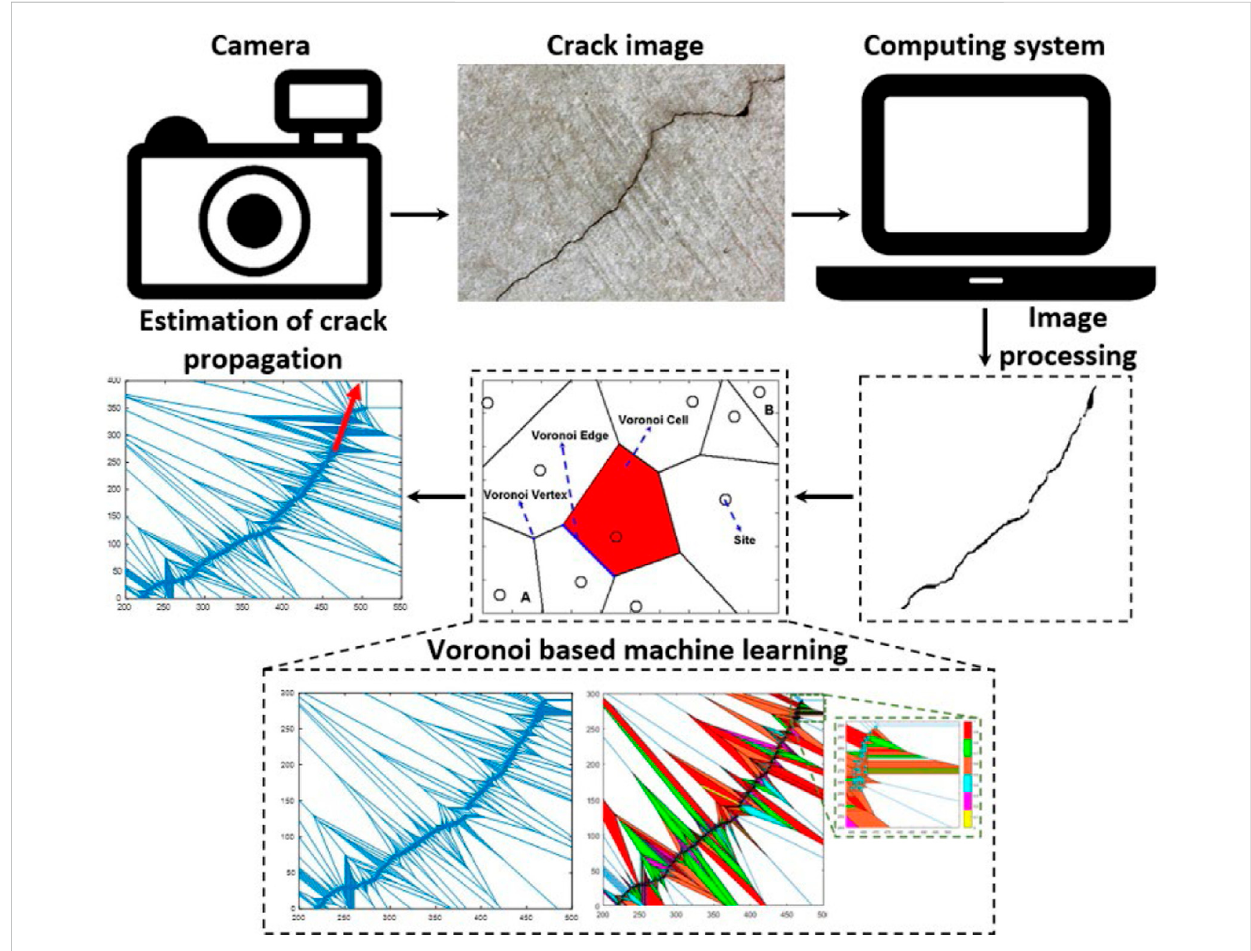
FIGURE 10 ML method for crack pattern and propagation detection (Bayar and Bilir, 2019)